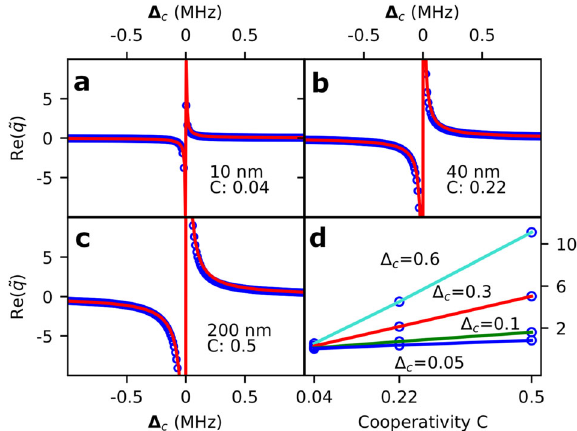
Fig. 2 Behavior of the real part of the asymmetry parameter Re e q ð Þ . a – c The dependence of Re ~ q ð Þ on cavity detuning Δ c for the case of 10, 40, and 200 nm thick permalloy fi lm. The blue circles are Re ~ q ð Þ values obtained via a fi t of the fi xed frequency lineshapes using Eq. (6). The red curves represent the behavior of Re ~ q ð Þ ¼ C κ = Δ c based on the generalized Fano model discussed in the